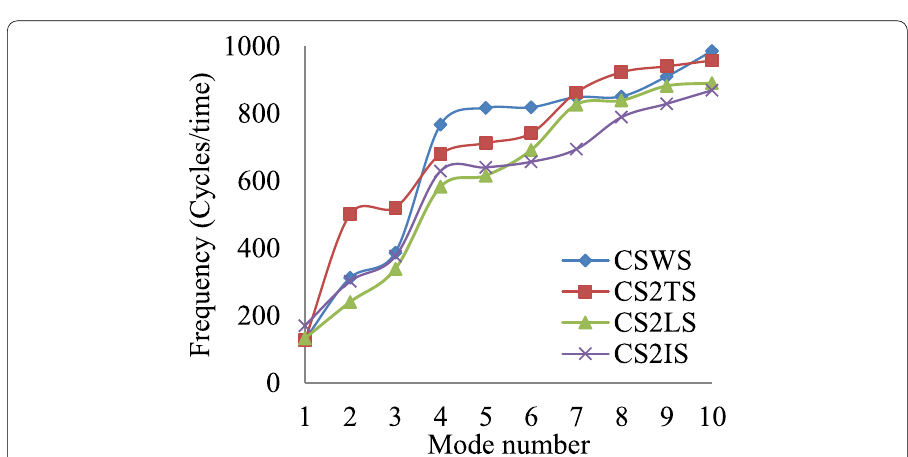
Fig. 8 Comparison of frequencies of theplates with two